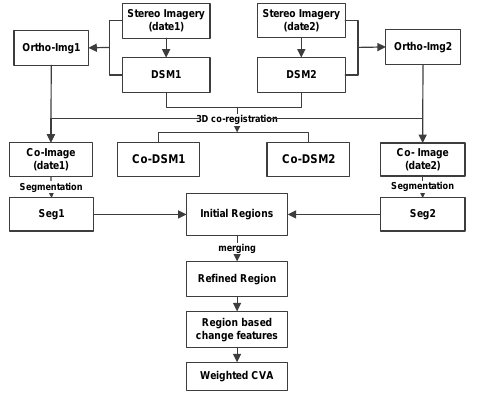
Figure 1. Flow chart of Method I (Tian et al., 2013b). 2.2 Method II: Decision fusion-based (Tian et al., 2013a)